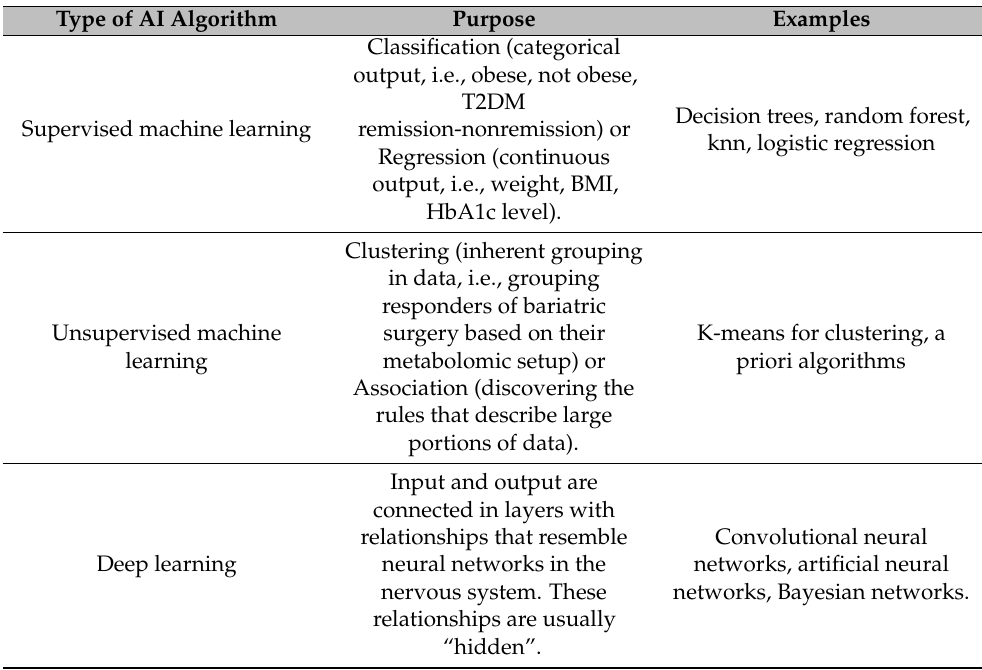
Table 1. The main types of artificial intelligence with examples of statistical approaches for each